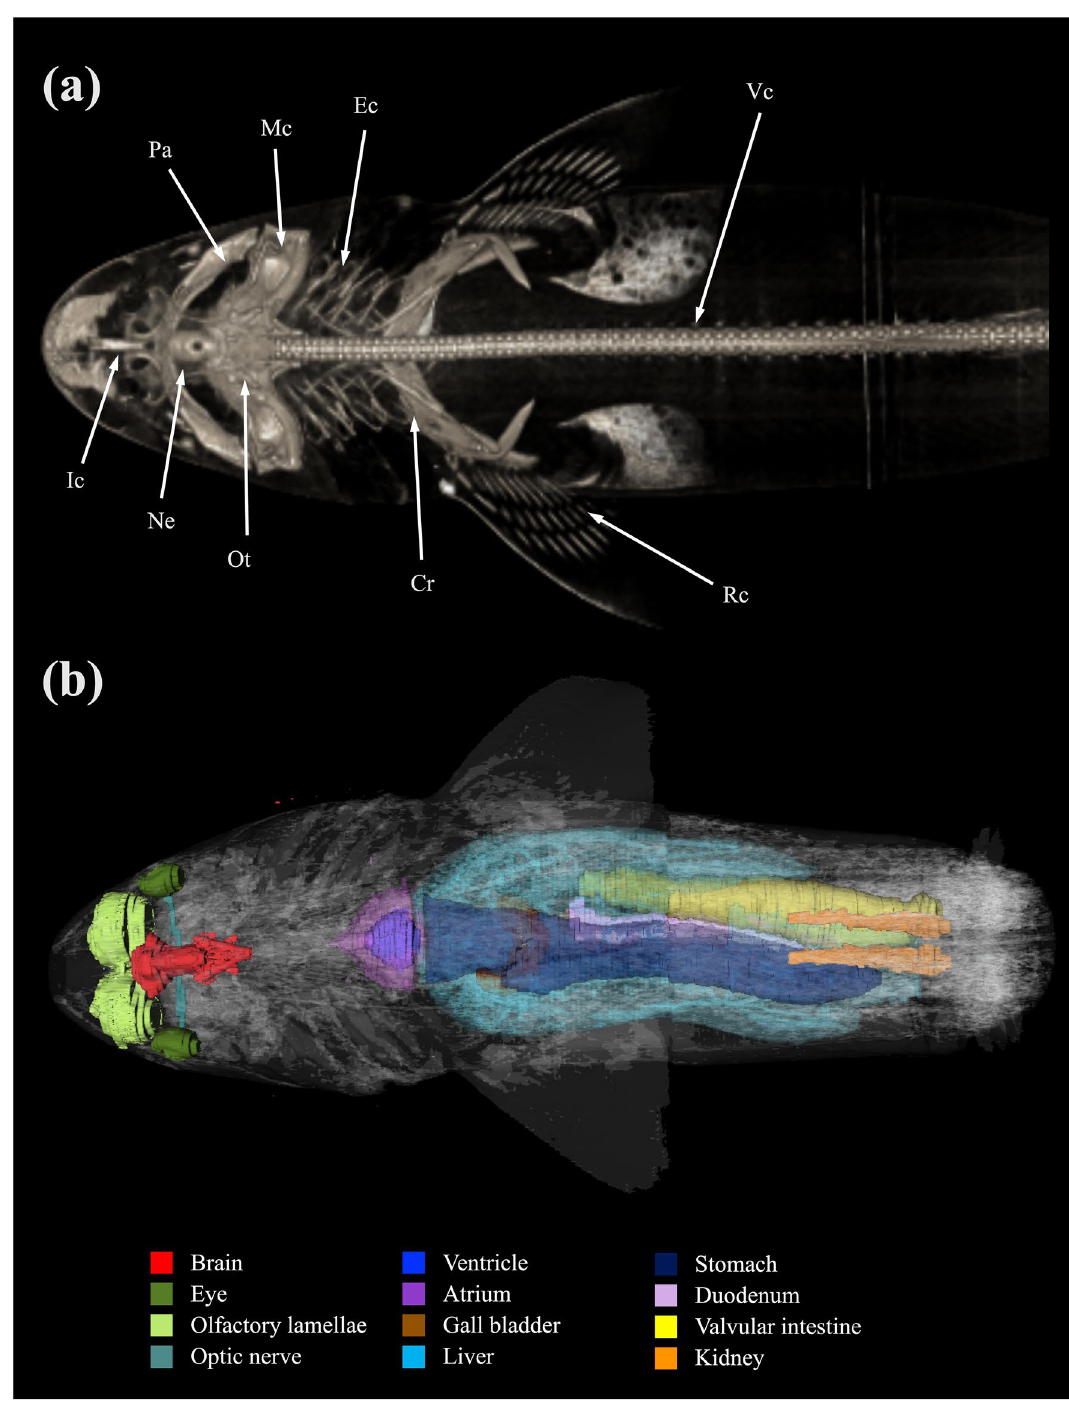
Figure 24. Three dimensional reconstructed images of ( a ) CT and ( b ) MRI showing major skeletal structures and organs respectively of a banded houndshark ( Triakis scyllium ). Cr Coracoid bar, Ec Epibranchial